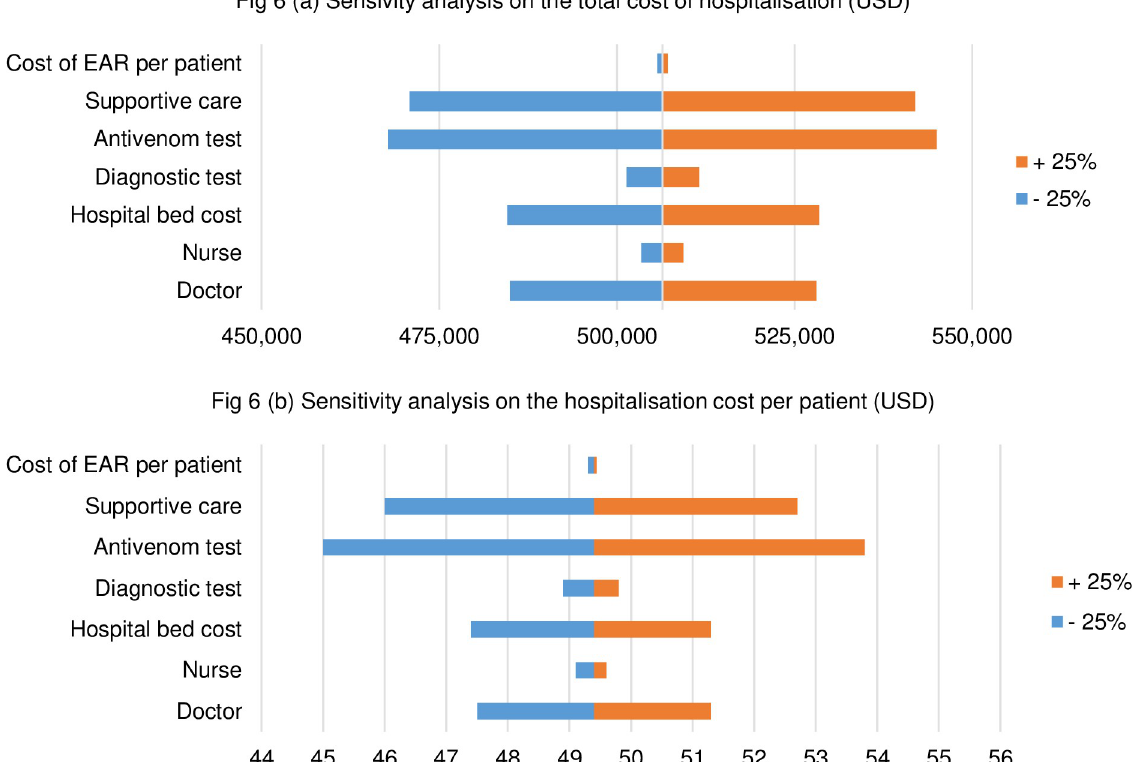
Fig 6. One way sensitivity analysis on the total hospitalization cost and the hospitalization cost per